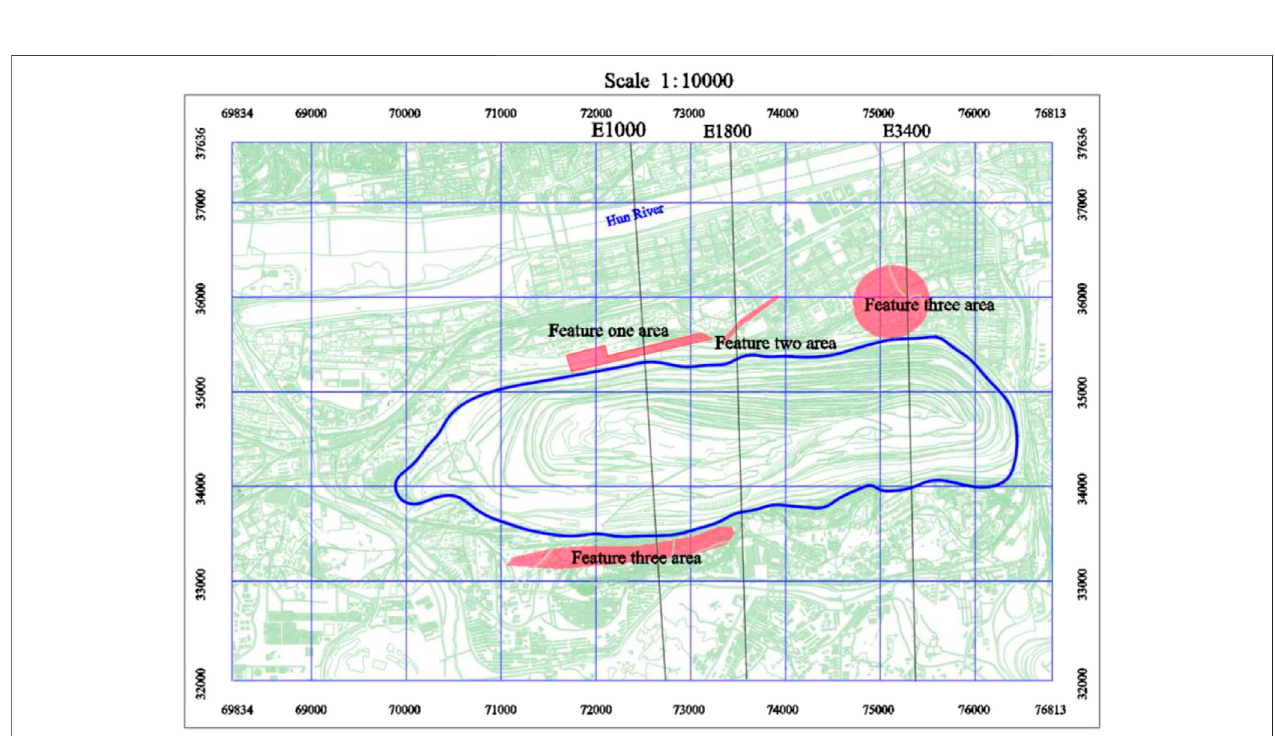
FIGURE 1 | Cumulative surface displacement map of west open pit and affected area from 2016 to 2020.